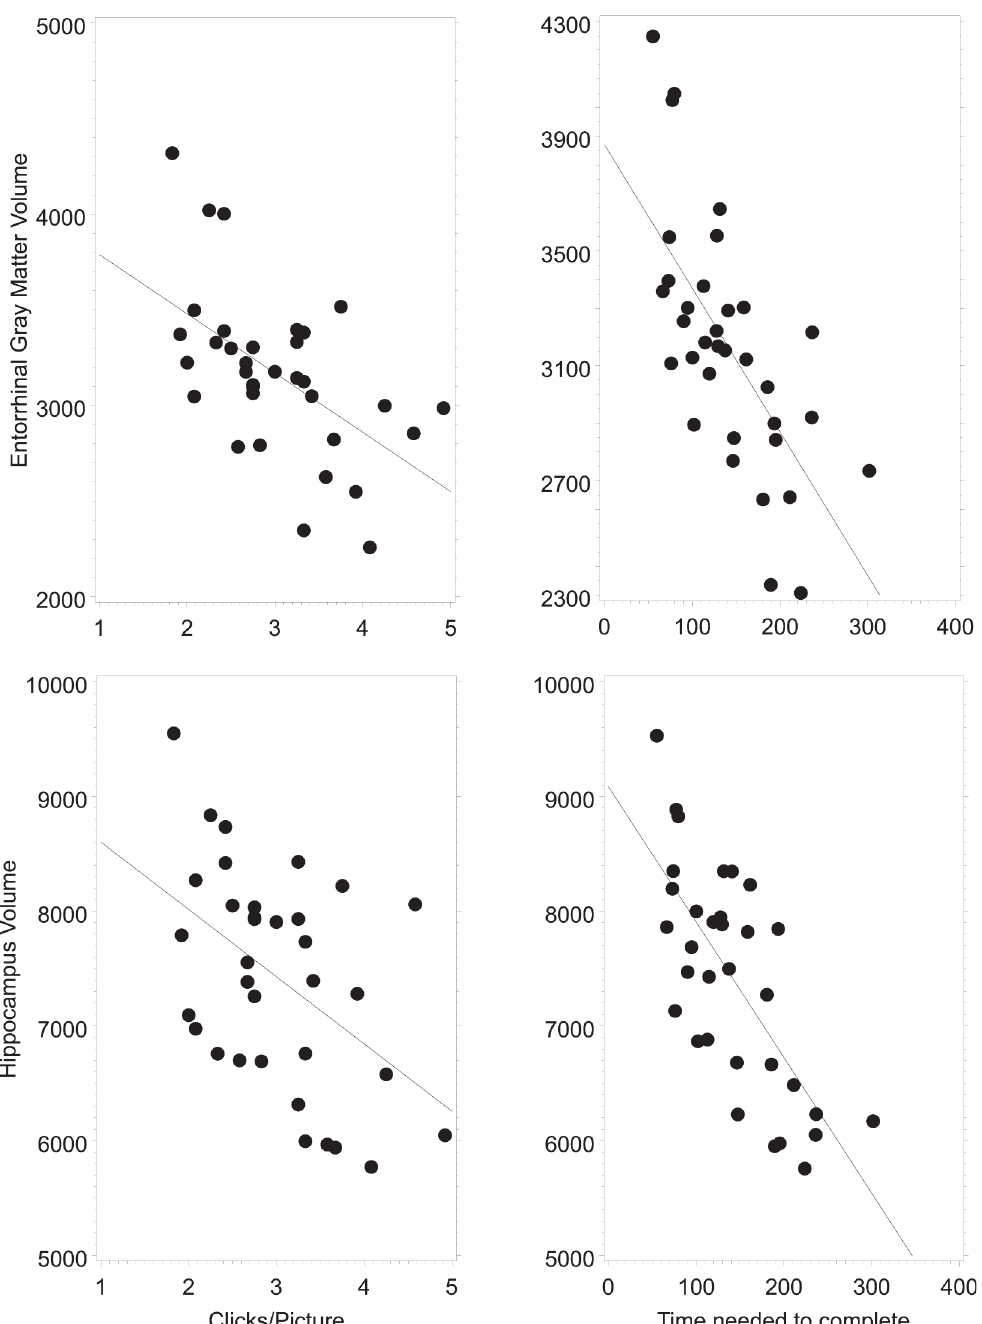
Fig 1. Correlations between the volume of the hippocampus, the volume of the entorhinal cortex, and the results of the memory game. Results of the memory game were assessed by the time needed to complete the game (panels on the left) and the trials or clicks needed to find a pair of shapes or pictures (panels on the right). Two upper panels: Volume of the Entorhinal Cortex. Two lower panels: Volume of the Hippocampus. Volumes are predicted from the General Linear Model analysis.